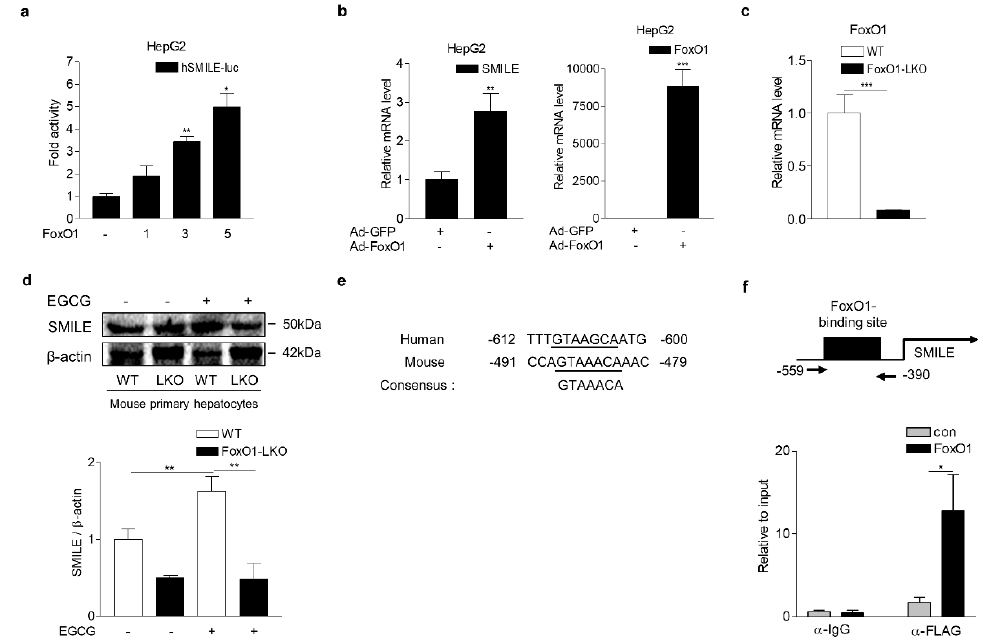
Figure 5. FoxO1 upregulates SMILE expression in hepatocytes ( a ) SMILE promoter activity by FoxO1. HepG2 cells were transfected with vectors encoding hSMILE-luc and FoxO1 (1, 100 ng; 3, 300 ng; 5, 500 ng). ( b ) FoxO1 increases SMILE mRNA expression. HepG2 cells were infected with Ad-GFP (10 MOI) or Ad-FoxO1 (10 MOI) for 48 h. ( c ) Q-PCR analysis showing the efficiency of FoxO1 knockdown in primary hepatocytes isolated from WT and FoxO1-LKO mice. ( d ) EGCG effect on SMILE protein levels in primary hepatocytes isolated from WT and FoxO1-LKO mice. Mouse primary hepatocytes were treated with EGCG (100 μ M) for 12 h. Gels for western blot analysis were run under the same experimental conditions. ( e ) Alignment of FoxO1 binding sequences on human and mouse SMILE promoter. Underlined letters indicate consensus FoxO1 binding sequences. ( f ) ChIP assay showing FoxO1 binding to SMILE promoter. HepG2 cells were transfected with vectors encoding SMILE promoter and FLAG-FoxO1. Soluble chromatin was immunoprecipitated using anti-FLAG antibody. ChIP signals were measured using Q-PCR. The independent experiments were repeated at least twice. The values are presented as means ± SD. * P < 0.05, ** P < 0.01, *** P < 0.001 using two-tailed Student’s t -test.